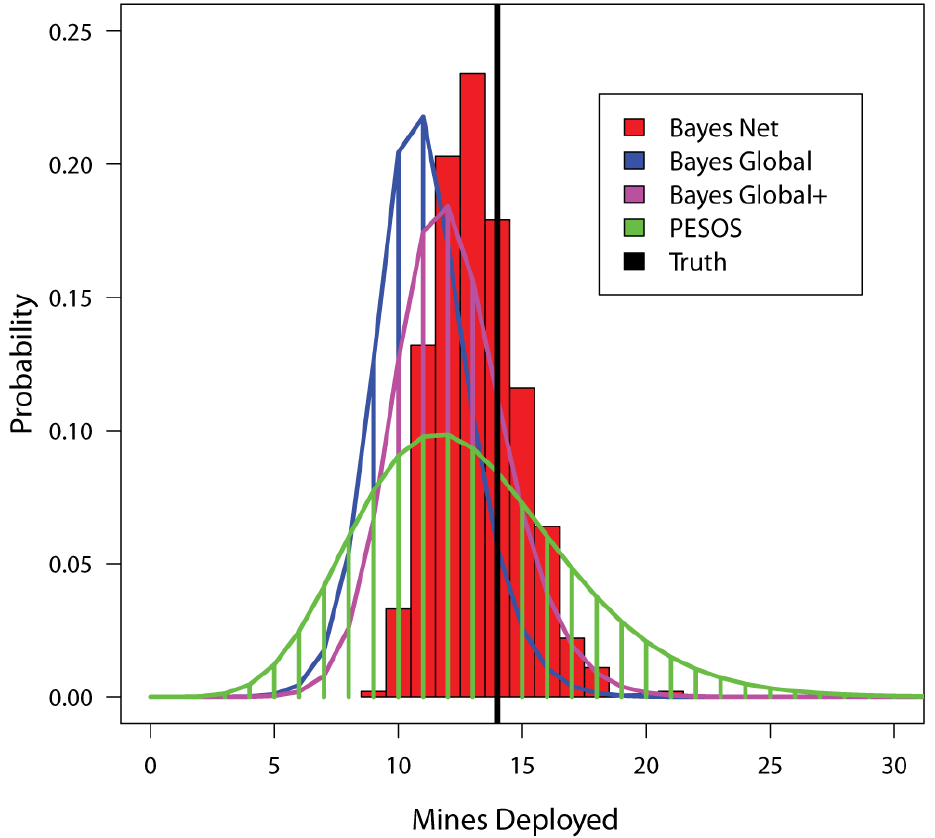
Figure 4. This figure compares estimation results from four methods for the number of mines deployed over all the cells ( M ). It is produced from the first dataset of simulated minefields, in which some of the MILCOs are left unidentified. In this case, 5 of the 69 MILCOs were left unidentified. Table 4. Performance results for each approach to estimating M , averaged over the 40 simulated